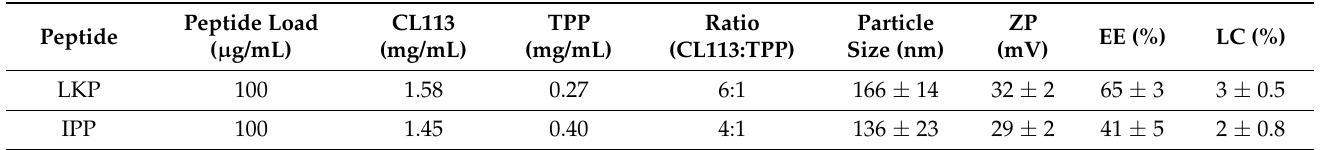
Table 1. Physicochemical characteristics of loaded peptide nanoparticles at optimised ratio of CL113: TPP.